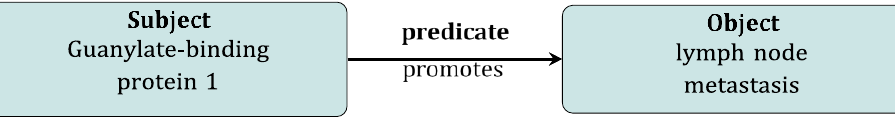
Figure 1. Resource Description Framework example.